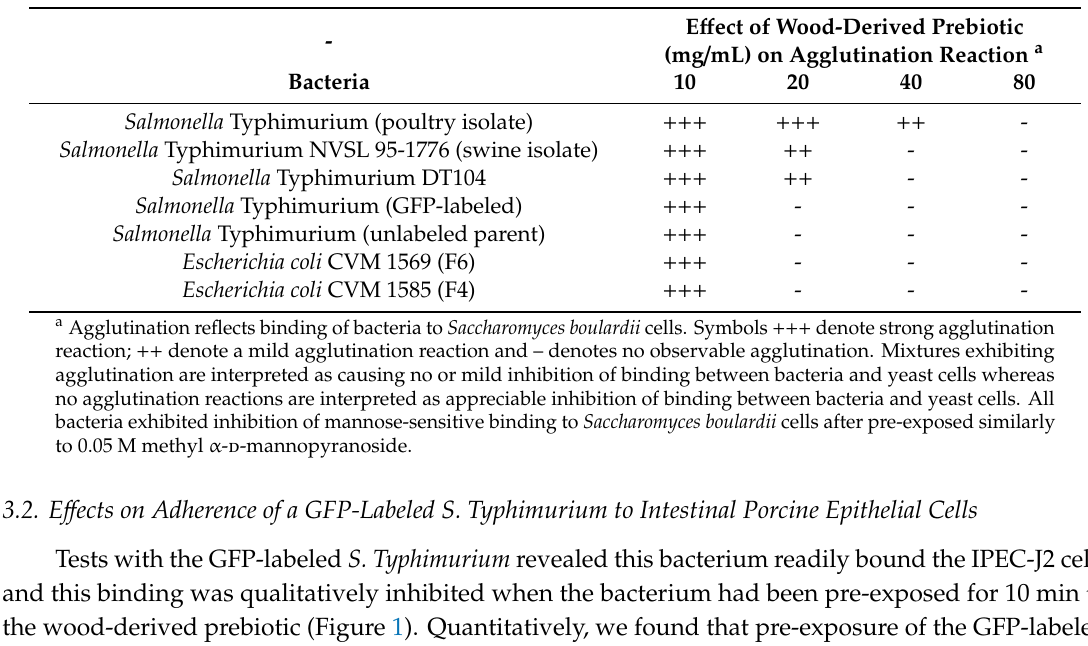
Table 1. E ff ect of wood-derived prebiotic on fimbrial-binding of select Salmonella enterica and Escherichia coli strains to Sacchaomyces